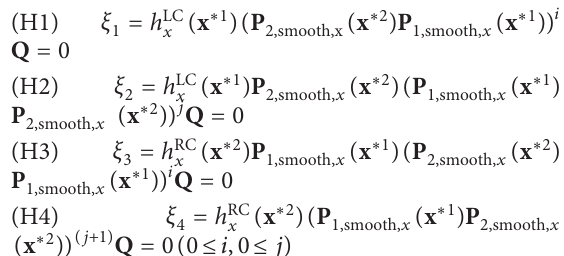
Figure 6: The diagram of codimension-two grazing bifurcation points. The black solid line represents the grazing curve, and the points on the line represent the codimension-two grazing bifur- cation points.